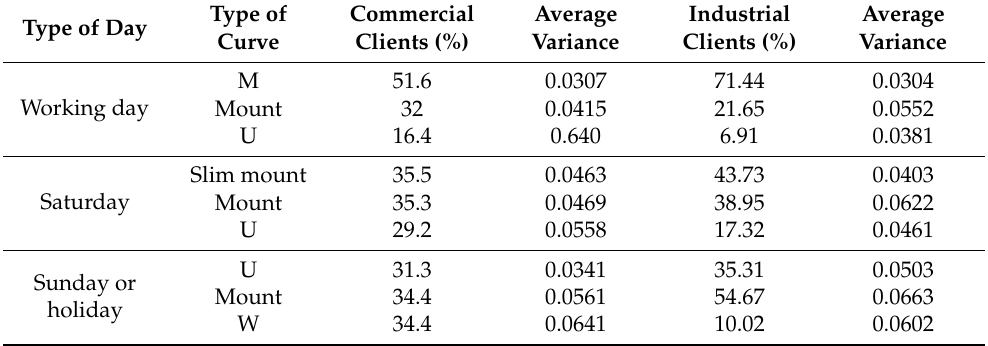
Average Industrial Variance Clients (%)